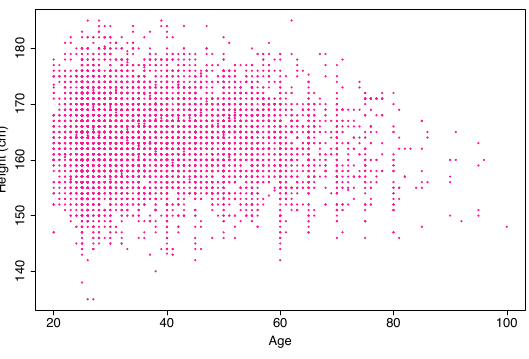
Figure 6. Distribution of male Height over Age providing an idea about the range of height over age and the density of the data over